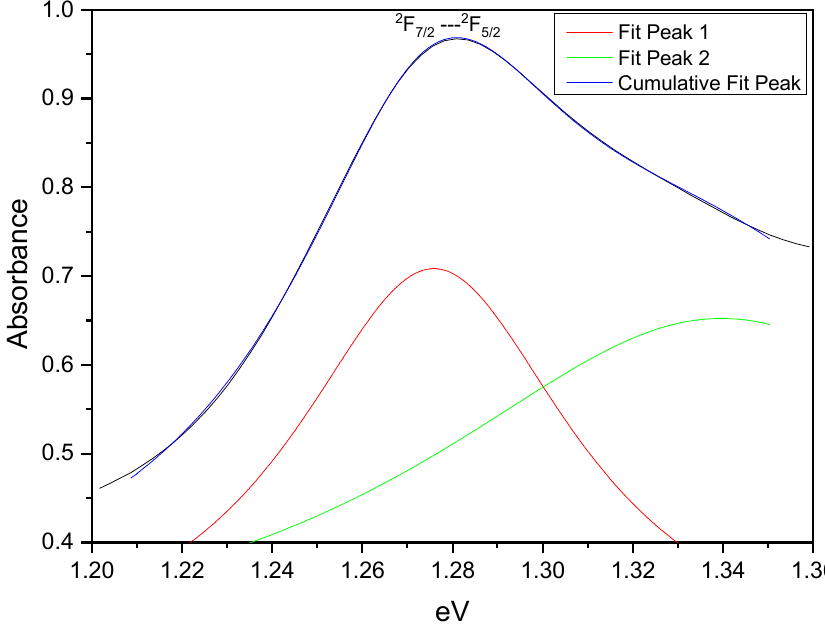
Figure 5. Deconvolution of the Yb 3+ absorption peak.